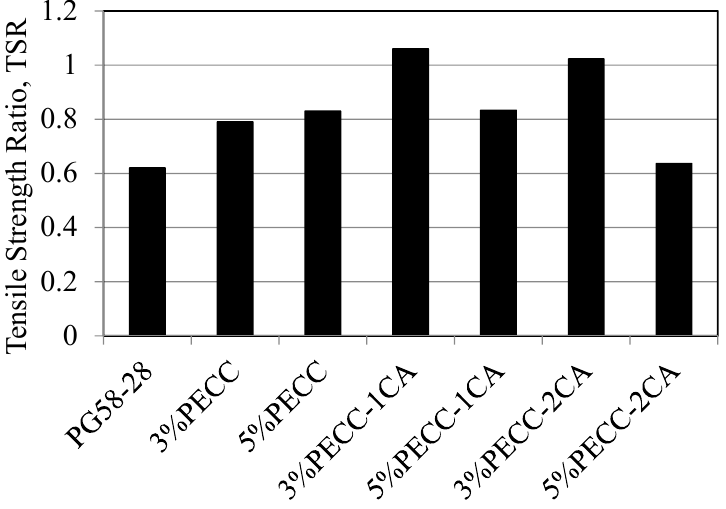
Figure 13. Moisture susceptibility of asphalt mixtures.